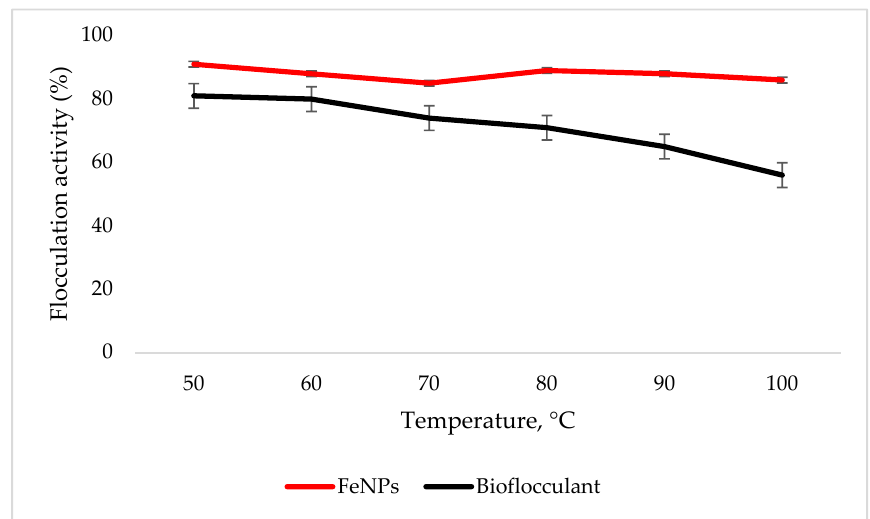
Figure 5. Temperature e ff ect on flocculation activity. Error bars denote statistical significance at (p < 0.05).